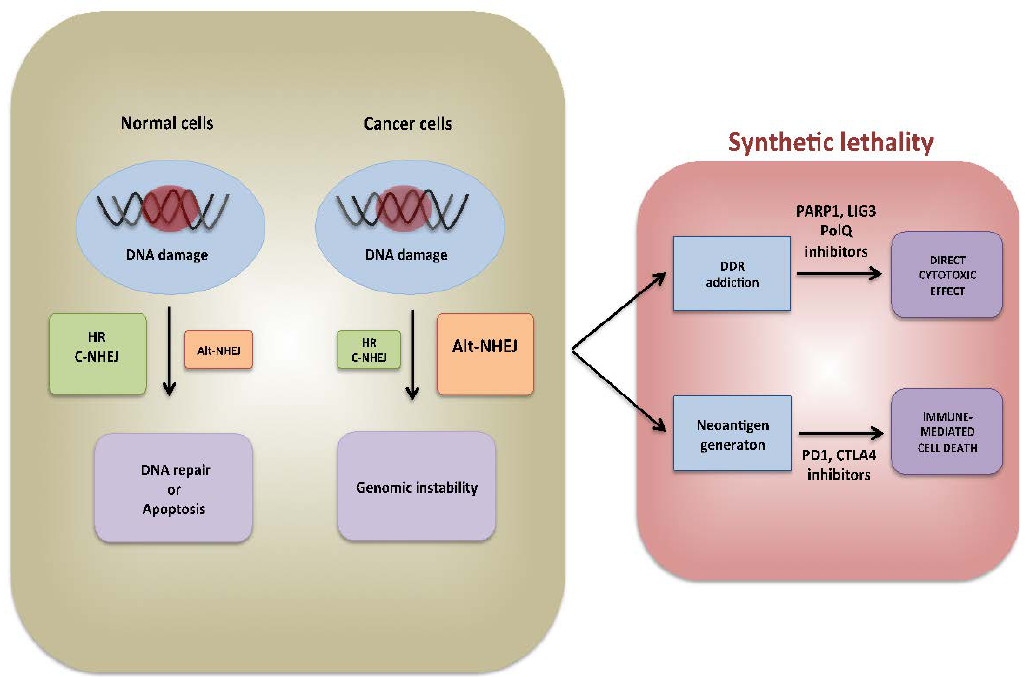
Figure 2. DNA repair dysregulation as cancer driver, therapeutic target, and biomarker of immunotherapy sensitivity. In normal cells, HR and c-NHEJ pathways work together to avoid dangerous effects of unrepaired DSBs. In cancer cells DSBs are instead often repaired erroneously by Alt-NHEJ, leading to genomic instability which could drive oncogenic transformation and progression. However, at the same time, these events represent an Achilles’ heel of cancer which could be therapeutically exploited by a synthetic lethality approach and could also offer new biomarker of responsiveness to immunotherapy. DSB, double strand break; DDR, dNA damage response; HR, homologous recombination; C-NHEJ, classical-non homologous end joining; Alt-NHEJ, alternative-non homologous end joining .